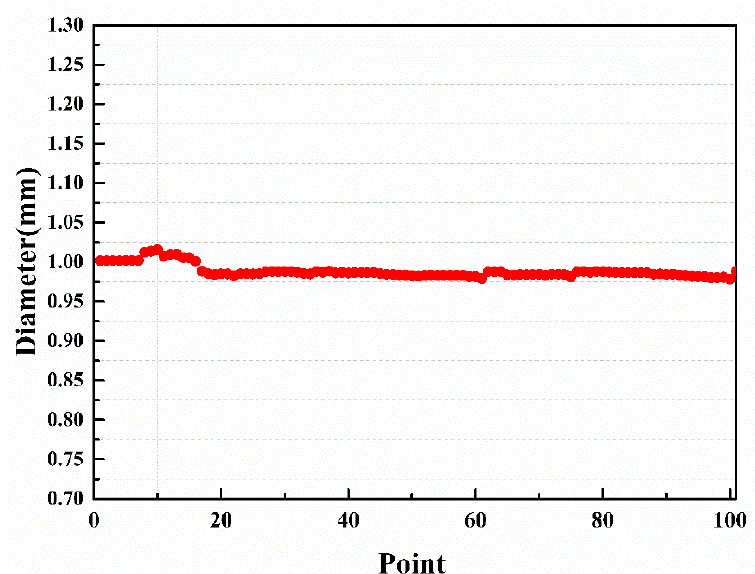
Figure 5. The diameter fluctuations of the Yb-doped LuAG SCF.